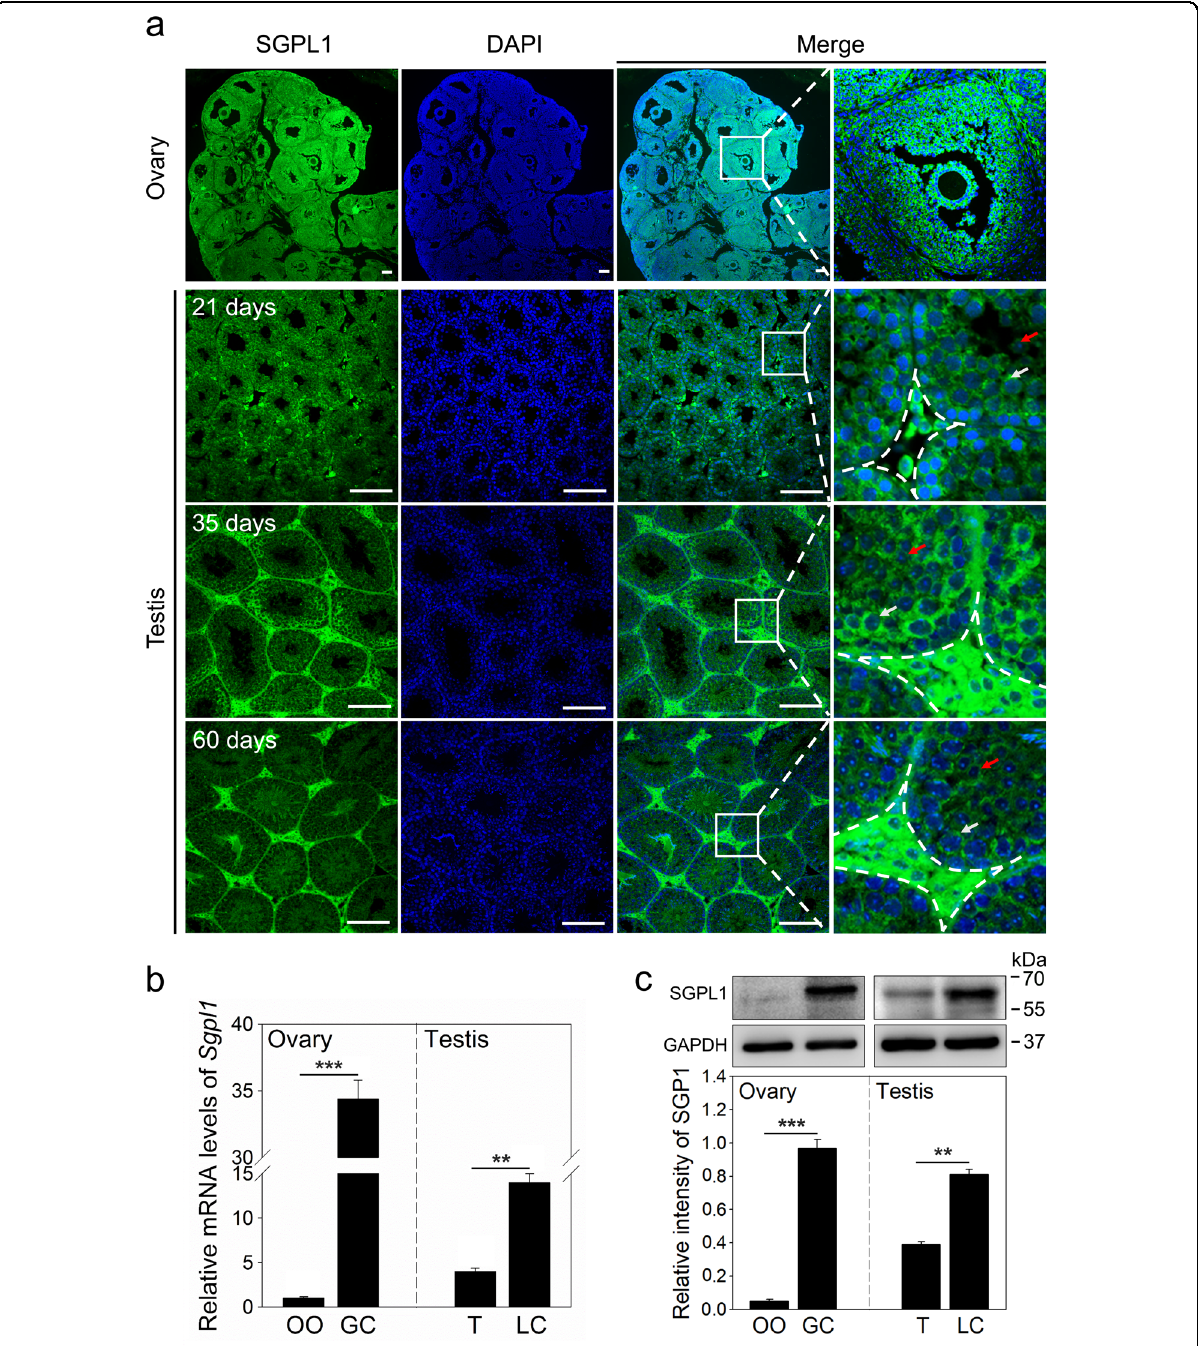
Fig. 1 The expression pattern of SGPL1 in mouse gonads. a Immuno fl uorescence analysis of SGPL1 (green) in ovaries isolated from eCG-primed mice and in testes isolated from 21-, 35-, and 60-day-old mice. ( n = 3 independent experiments). The nuclei were counterstained by DAPI (blue). The small white boxes indicate the locations of the enlarged areas, as shown in the following images. The cells in the dashed line box are Leydig cells. The white arrows show the spermatocytes, and the red arrows show the round spermatids. Scale bars: 100 μ m. The mRNA ( b ) and protein ( c ) levels of SGPL1 in different cells and tissues isolated from 21-day-old mouse gonads ( n = 4 independent experiments). GAPDH was used as a loading control. Bars indicate the mean ± SEM. ** p < 0.01 and *** p < 0.001. OO oocyte, GC granulosa cell, T testis, LC Leydig